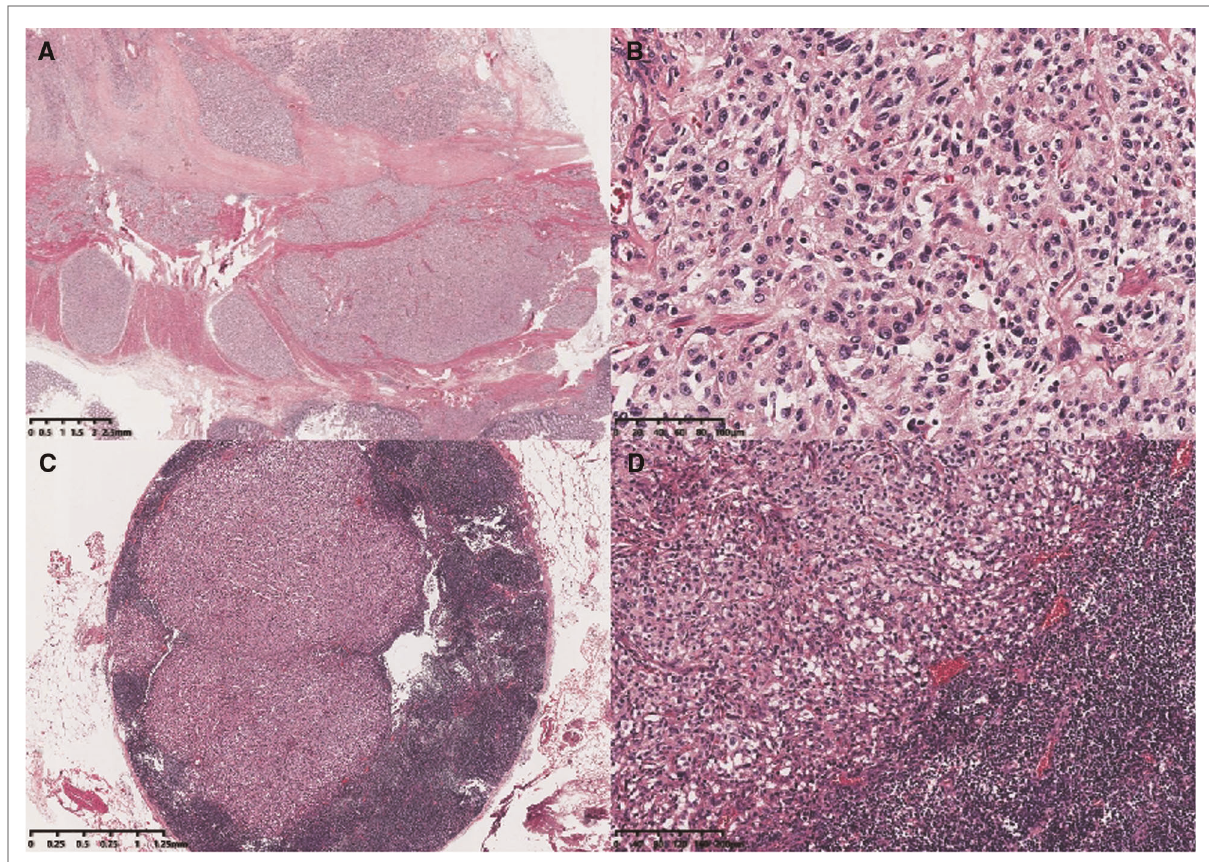
FIGURE 1 Microscopic features. The main body of the tumor was located in the muscularis and subserosa of the colonic wall ( A , ×6). At high magni fi cation, the tumor morphology appeared as a nest-like and organ-like structure (Zellballen pattern) ( B , ×200). Lymph-node metastasis ( C , ×20; D ,